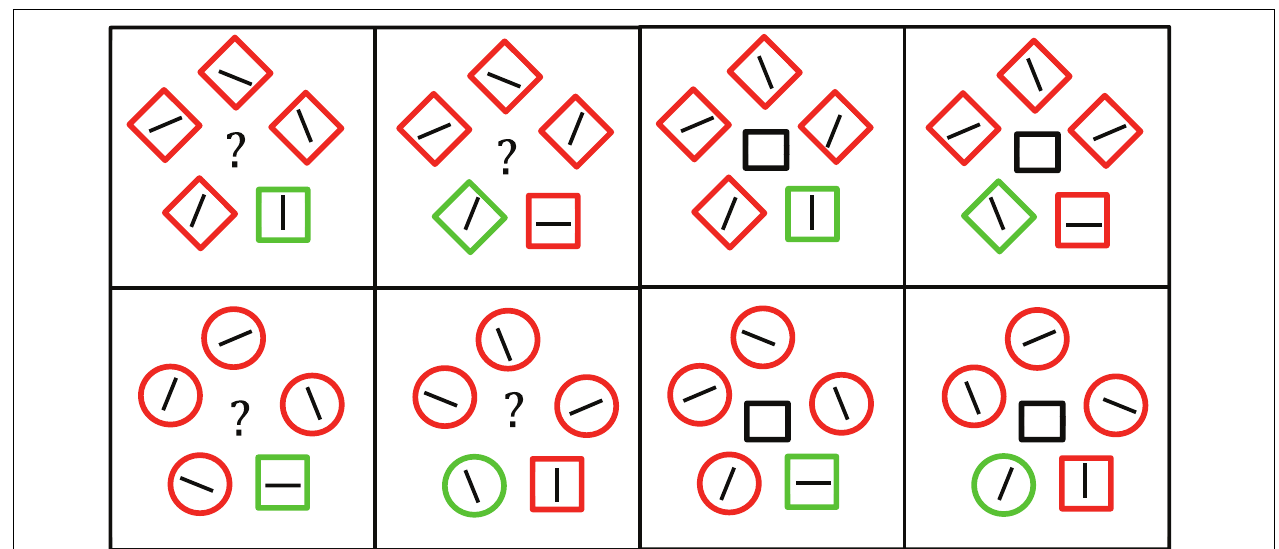
therightsidearecuedtrials,wherethecentrally-presentedcueindicatedwhich of two shapes would be the upcoming target. In both conditions, half of the trials were congruent and half of the trials were incongruent. In the actual experiment,thecentralcuesprecededthesearcharray.Imagesarenottoscale.